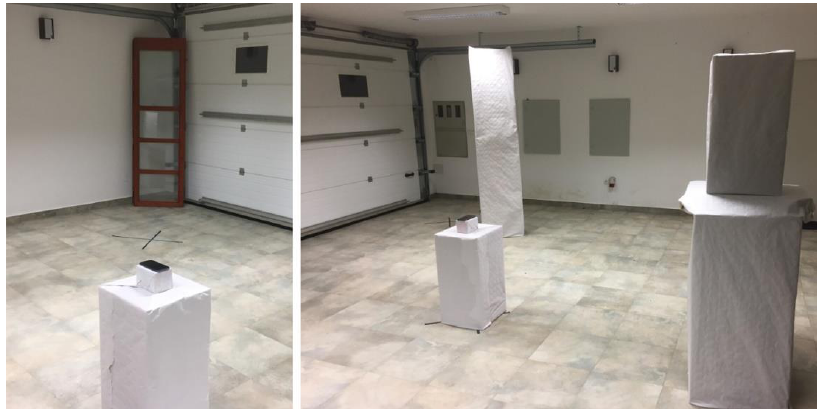
Figure 5. Testing environment with medium obstacle severity. Figure 4. Testing environment with medium obstacle severity. Figure 6. Testing environment with medium obstacle severity.